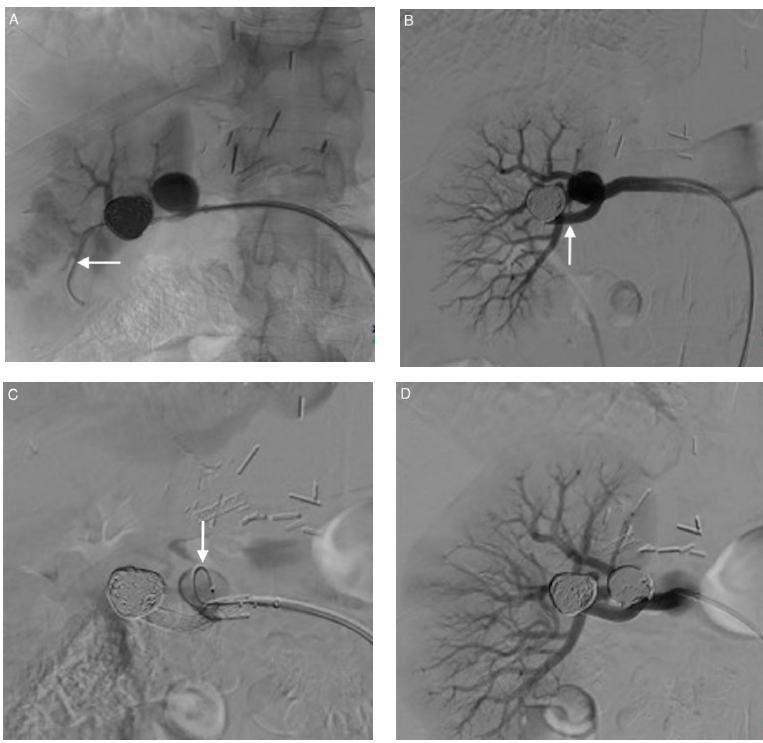
Figure 3. Exclusion of aneurysm 6 in a second session: stent-assisted coiling. ( A ) A guidewire is navigated beyond the aneurysm into an inferior segmental branch (arrow). ( B ) A bare stent (arrow) is deployed over the aneurysm neck, extending from the main renal artery to the inferior branch of the renal artery. ( C ) Catheterization of the aneurysm sac through the mesh of the stent using a microcatheter (arrow) and coiling of the sac. ( D ) Angiography performed at the end of the procedure showing complete exclusion of both aneurysms.